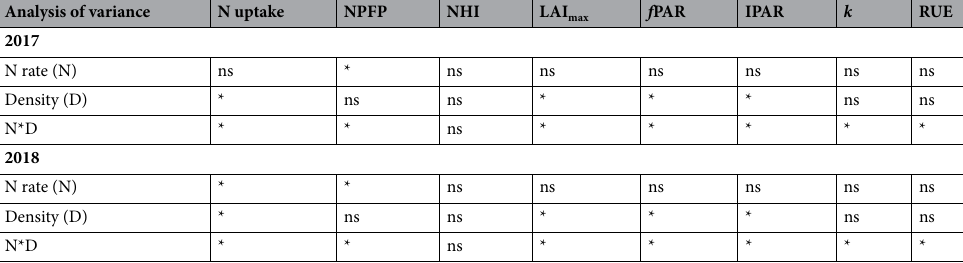
Table 2. Variance analysis for the N rate and density and their interactions effect on N uptake and use efficiency, and radiation capture and use efficiency. NPFP N partial factor productivity, NHI N harvest index, LAI max maximum leaf area index, fPAR fraction of PAR intercepted, IPAR cumulative intercepted PAR, k light extinction coefficient, RUE radiation use efficiency, ns no significant effects. *Significant effects at P < 0.05. **Significant effects at P < 0.01.